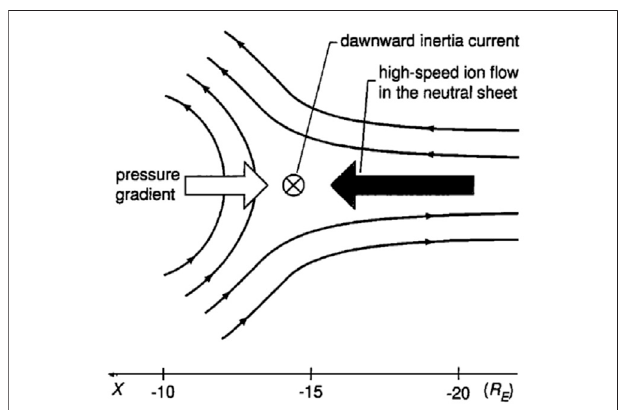
FIGURE 1 | Schematic picture of the proposed magnetic fi eld con fi guration during Earthward high-speed ion fl ow (looking from dusk to dawn).Thestoppingpointofthe fl owistheboundarybetweendipolarandtail- like magnetic fi elds which correspond to the inner edge of the neutral sheet. The boundary is formed by the downward inertia current that iscaused by braking of the Earthward ion fl ow and by the pileup of northward magnetic fl ux carried by the fl ow (Shiokawa et al.,